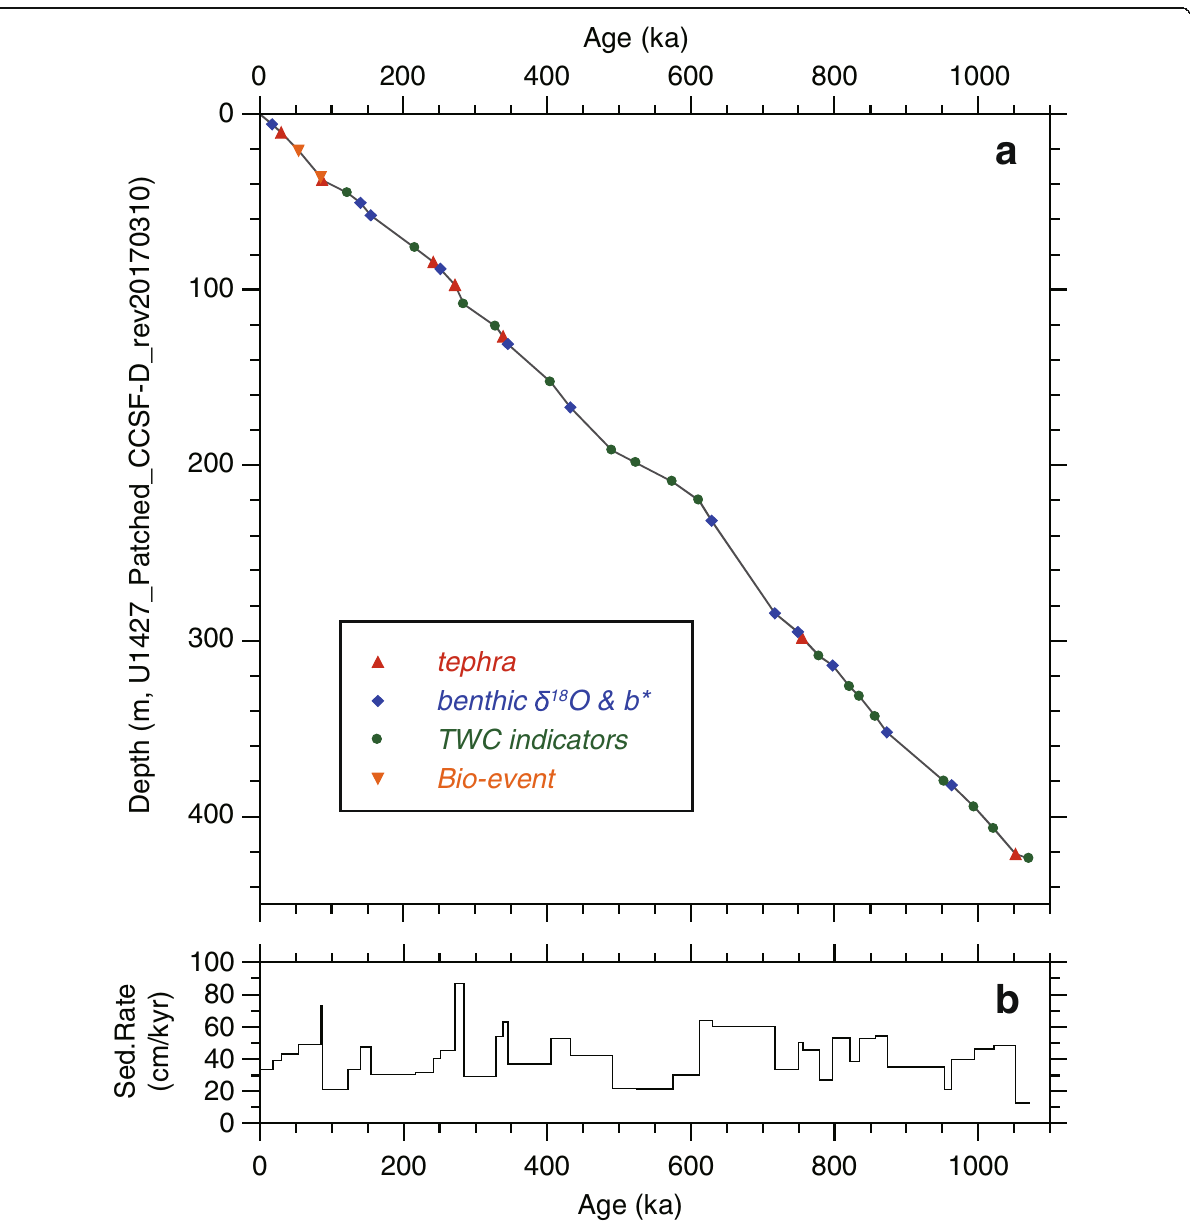
Fig. 8 Age – depth relationship at Site U1427 ( a ) and sedimentation rate ( b